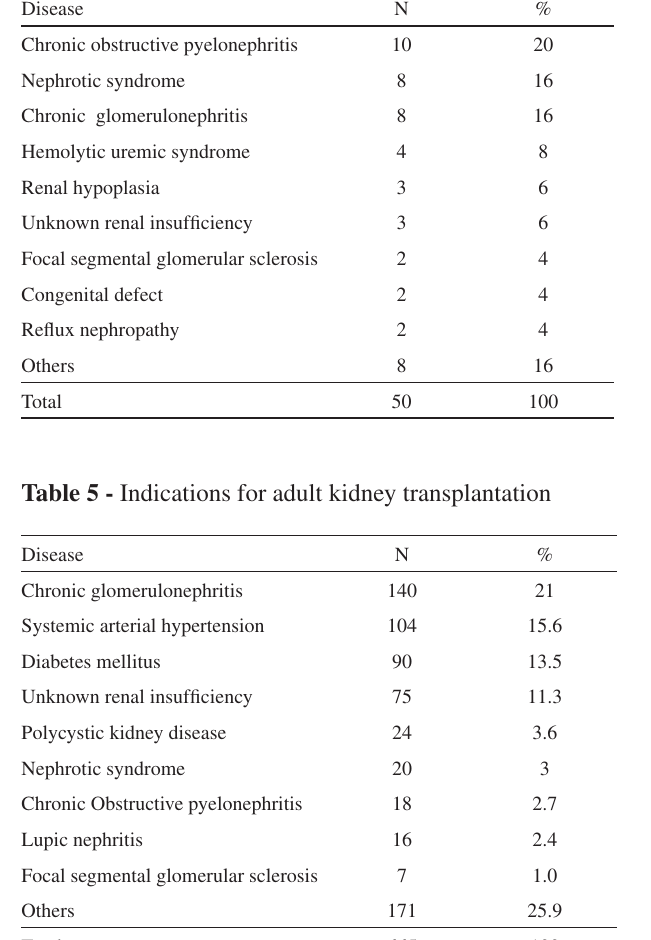
Table 4 - Indications for pediatric kidney transplantation